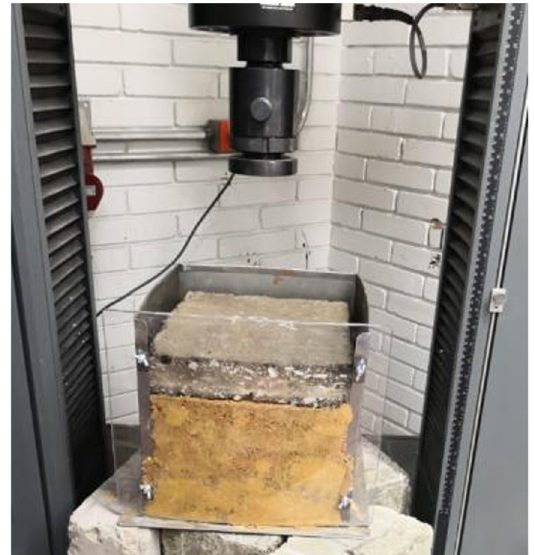
Figure 6. Geometrical configuration of the testing specimen with the granular base as a support.